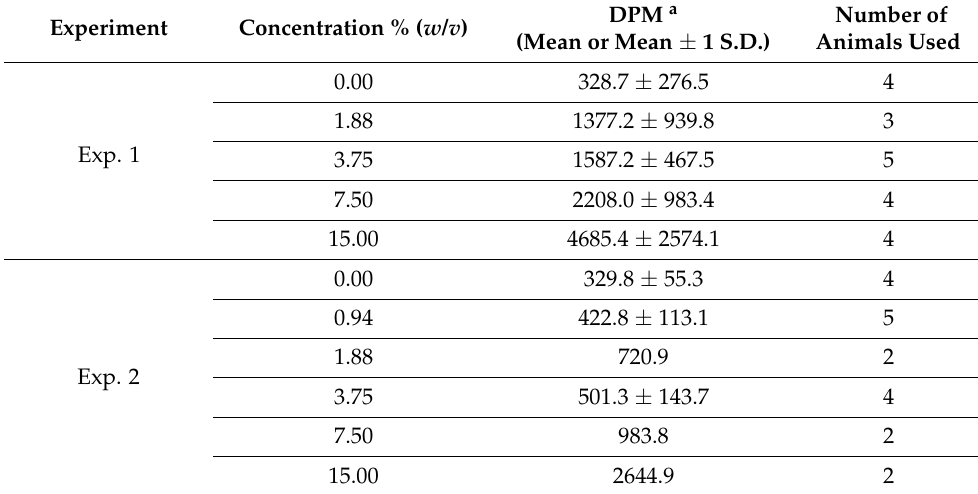
Figure 5. Evaluation of contact sensitization response to Brazilian green propolis (BGP) by LLNA. The stimulation index (SI) values of each mouse were calculated from DPM values (incorporation of [ 3 H]-thymidine in auricular lymph node cells). ( A ) First experiment ( n = 3–5); ( B ) second experiment ( n = 2–5). ( C ) Mean SI values calculated from the data shown in ( A , B ). Dashed lines indicate SI = 3. Table 1. Detailed data of local lymph node assay for Brazilian green propolis (BGP). Experiment